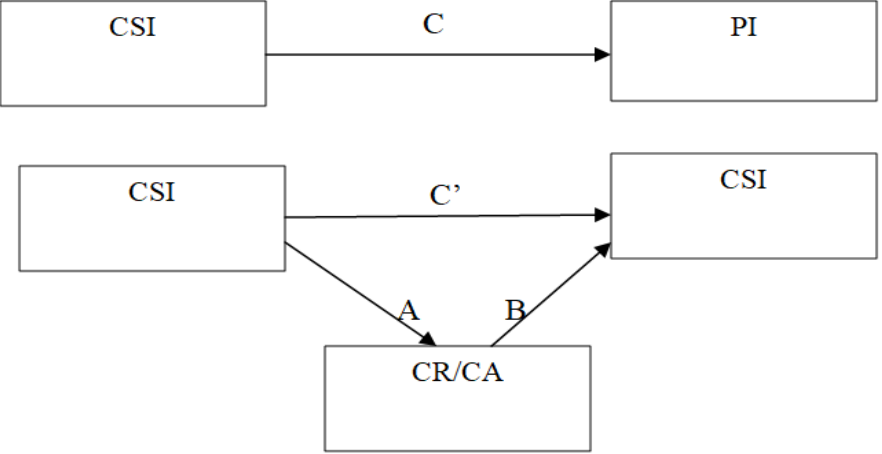
Figure 2: Direct and indirect effects associated with CR and CA as Mediators.